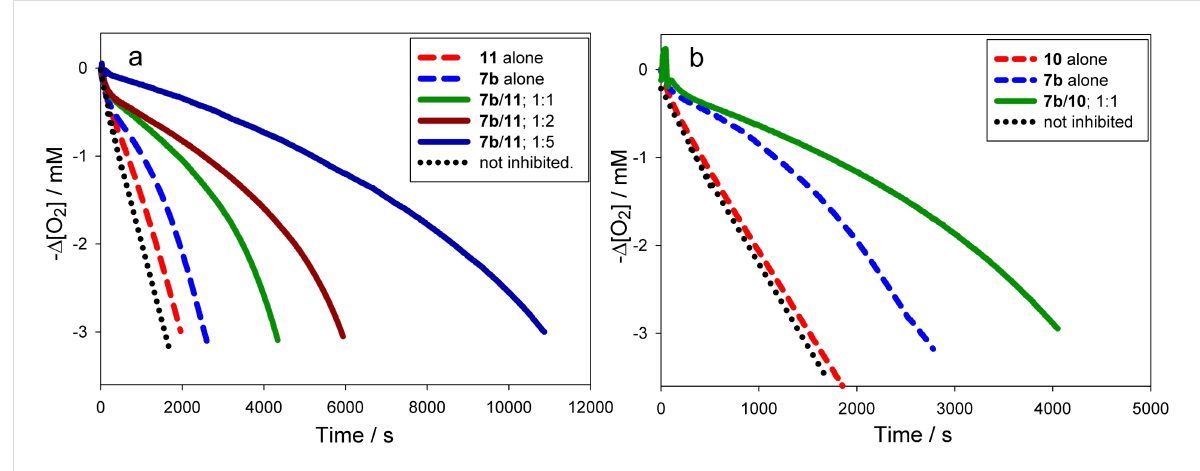
Figure 4: Oxygen-uptake plots recorded during the AIBN initiated autoxidation of styrene in chlorobenzene (50% v/v) at 303 K in the presence of compound 7b and/or 11 (either 6.1 × 10 − 6 M) (a) and corresponding plots using compound 10 as co-antioxidant